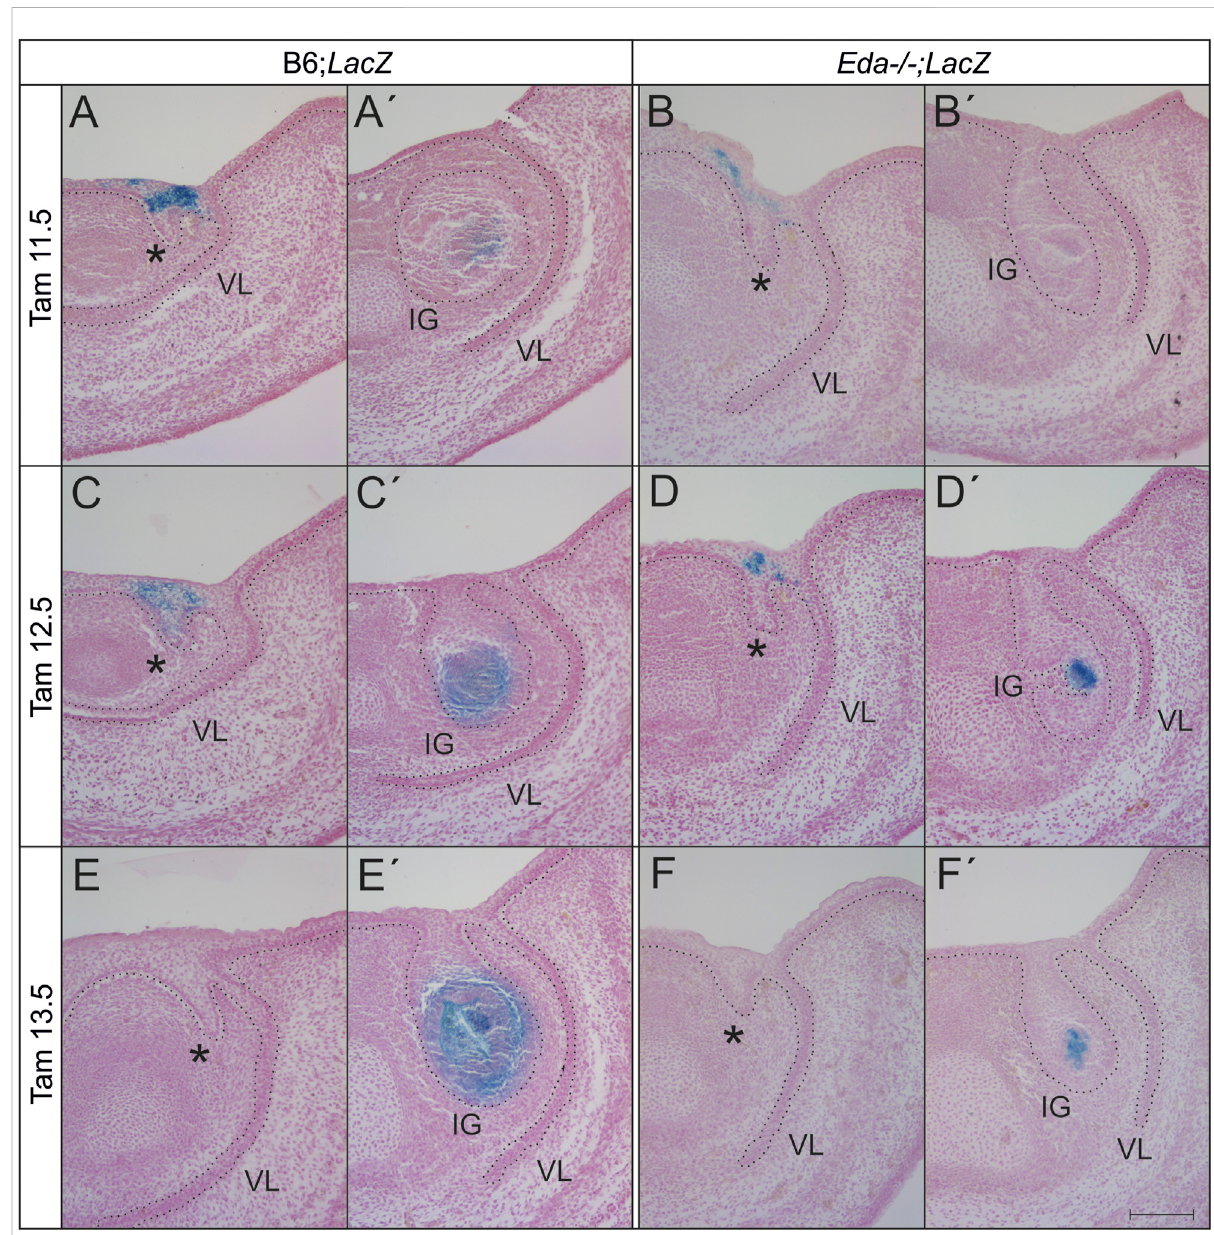
Thearea ofpresence ofthedescendants of celllineage expressing Shh atED11.5, 12.5or13.5and laterisreduced in Eda de fi cient incisor germs at ED14.5 and 15.5. After the tamoxifen administration at ED11.5 and 12.5, the anterior super fi cial area (asterisk, rudimentary incisor related) of X-gal positive cells (blue) appears to be similar in both Eda − / − ( Eda − / − ;LacZ ) and WT (B6; LacZ ) embryonic lower incisor germs at ED14.5 (A,B) and 15.5 (C,D) .However,theposteriorareaofpositivecells,directlyinthetoothgerm(IG)oftheprospectivefunctionalincisorisconsiderablyreducedin space in Eda de fi cient mice ( Eda − / − ;LacZ ) at the same stages (A 9 – D 9 ) . After the tamoxifen administration at ED13.5, the anterior superficial oral epitheliumadjacenttothetoothgermaswellasintheepithelialstalkoftheincisorgermwasnegativeinboth Eda − / − andcontrols (E,F) incontrastto the descendant cell population of the enamel knot area of incisor germ, which was in Eda − / − embryos signi fi cantly reduced (F 9 ) compared to controls (E 9 ) . VL – vestibular lamina. Dotted line delimits the epithelium. Bar: 100